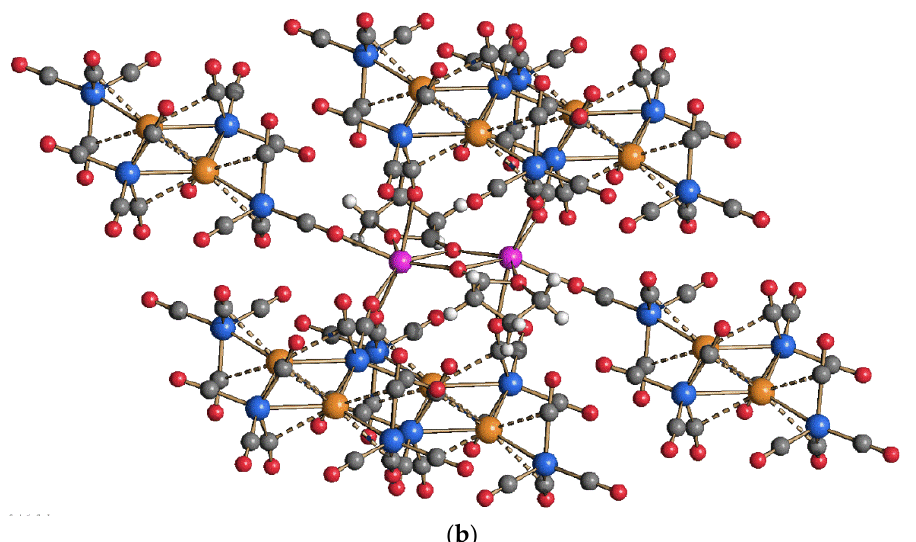
Figure 7. View of ( a ) the Na + coordination and ( b ) the isocarbonyl linkages present in the crystal packing of Na 2 ( 5 )·C 4 H 6 O 2 . Sub Van der Waals Ag ··· C(O) contacts are represented as fragmented lines (orange, Ag; blue, Co; red, O; grey, C; white, H; purple, Na).